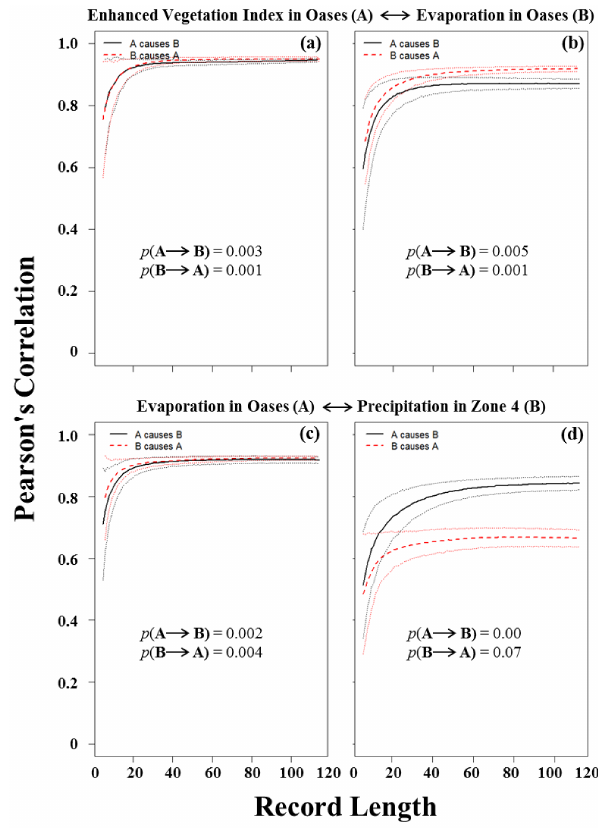
Figure 5. Predictive-skill curves based on Pearson’s correlation co- efficients for convergent cross-mapping of enhanced vegetation in- dex (EVI) with evaporation in the oases (a, b) and evaporation in the oases with precipitation production in zone 4 (c, d) . Plots (a) and (c) are based on the original time series data, whereas plots (b) and (d) are based on the “first differencing” of the original data. Dotted lines on either side of the predictive-skill curves represent the ± standard error of estimate assessed from bootstrapping based on 3000 iterations. Convergent cross-mapping is based on proce- dures written in the R-programming language initially developed by Clark et al. (2015). The feature that assures causality in vari- ables is the convergence in the predictive curves as record length increases. Lack of convergence with low Pearson’s correlation co- efficients indicates lack of causality. The variable with the highest Pearson’s correlation coefficients indicates the stronger controlling variable. When curves for both variables are convergent (as is the case here), bi-directional causality and, thus, feedback is indicated. Analyses are based on embedded dimensions and time delays of 4 and 1, respectively (Sugihara et al.,